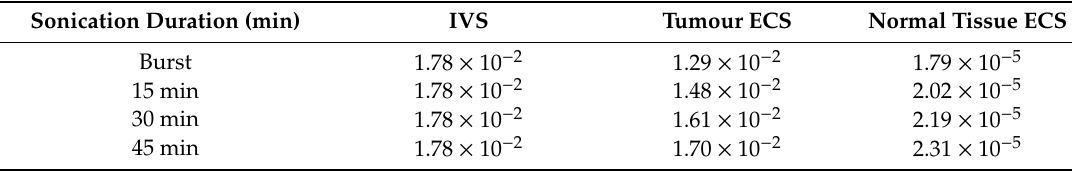
Table 7. AUC 24h (mg/mL∙s) of the treatments with different sonication durations. Sonication Duration